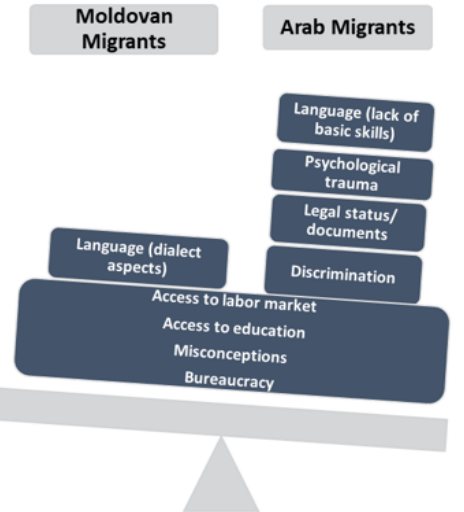
Figure 1. Integration barriers in the case of Moldovan and Arab migrants in Romania (elaborated by the authors).